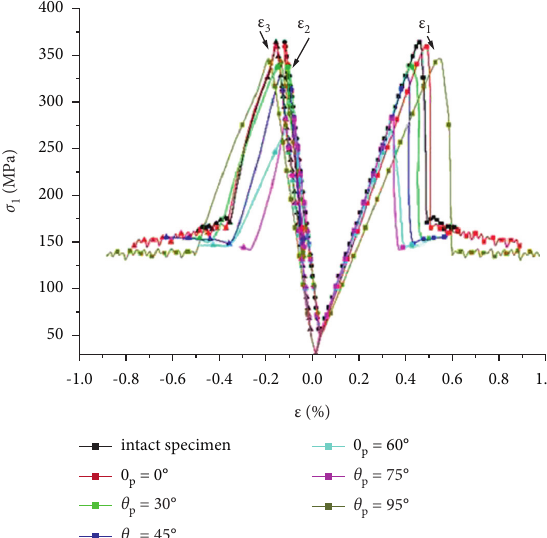
Figure 8: The stress-strain curves of specimens containing single crack with different preferential angles.